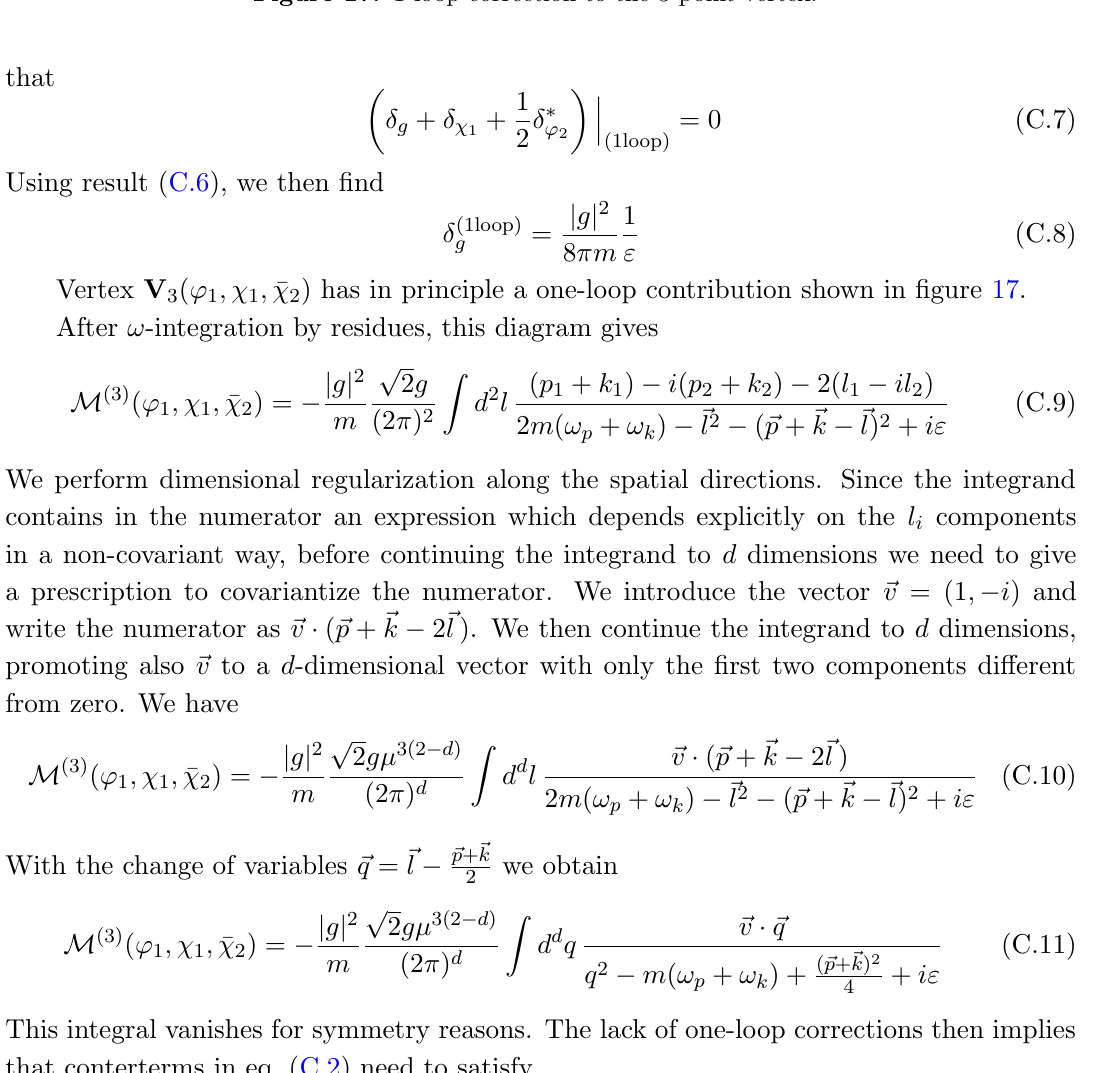
Figure 17. 1-loop correction to the 3-point